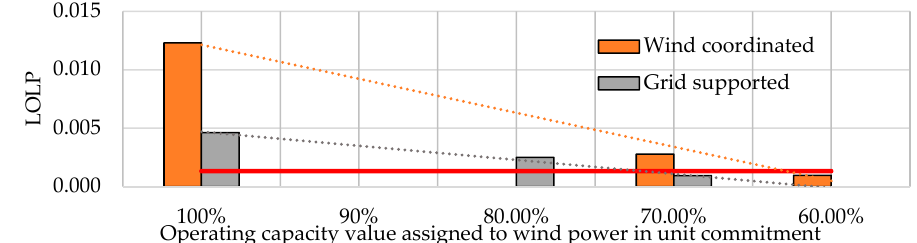
Figure 11. Operating capacity value of wind power with different ESS operational strategies.